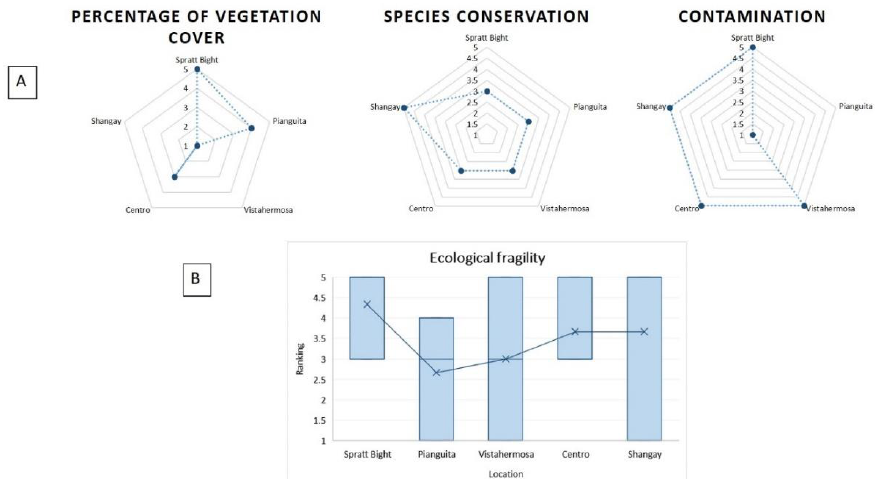
Figure 10. ( A ) Ranking of four variables representing ecological fragility for two study areas (and five villages): San Andrés, Caribbean Coast (Spratt Bight) and La Bocana, Pacific Coast (Pianguita, Vistahermosa, Centro, Shangay) of Colombia. ( B ) Minimum and maximum values of ecological fragility for each village and average rank. Results are shown by ranking, given that units of analysis are rank levels and not segments, as was the case for hazard.